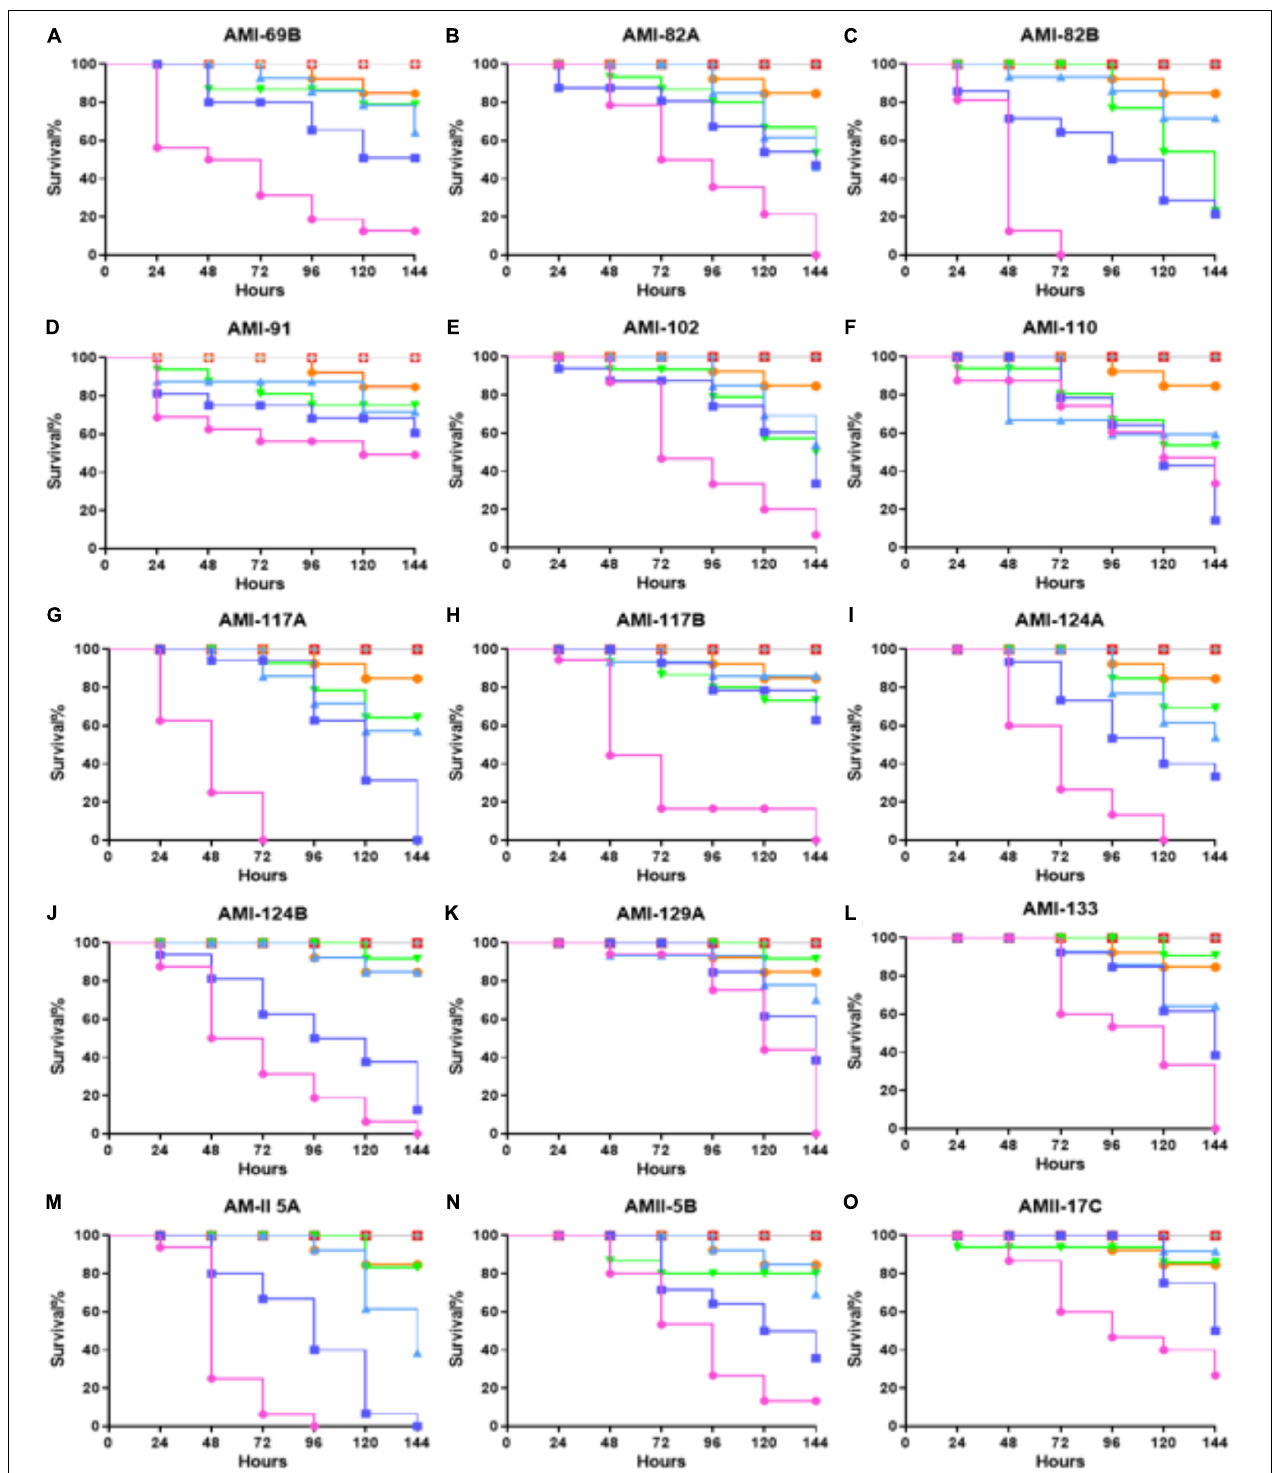
FIGURE 2 | Whole larvae survival assay for toxicity assessment of the test compounds. Plotted here (A–O) are the toxicity profiles of selected compounds showing at least LC 50 of > 150 h for some portion of the tested concentrations. Legend represents: ; No treatment: ; PBS treated: ; DMSO treated: ; Vancomycin treated at 25 mg/Kg: ; representative compound treated at 0.5 mg/Kg: ; 5 mg /Kg: ; 15 mg/Kg and ; 25 mg/Kg. Kaplan–Meier survival curves were plotted with GraphPad Prism version 6.048.4.1 (GraphPad Software, La Jolla, CA, United States). Statistical analysis was carried out using a log-rank (Mantel-Cox) test comparing the each group to the PBS treated group. p value < 0.05 was considered